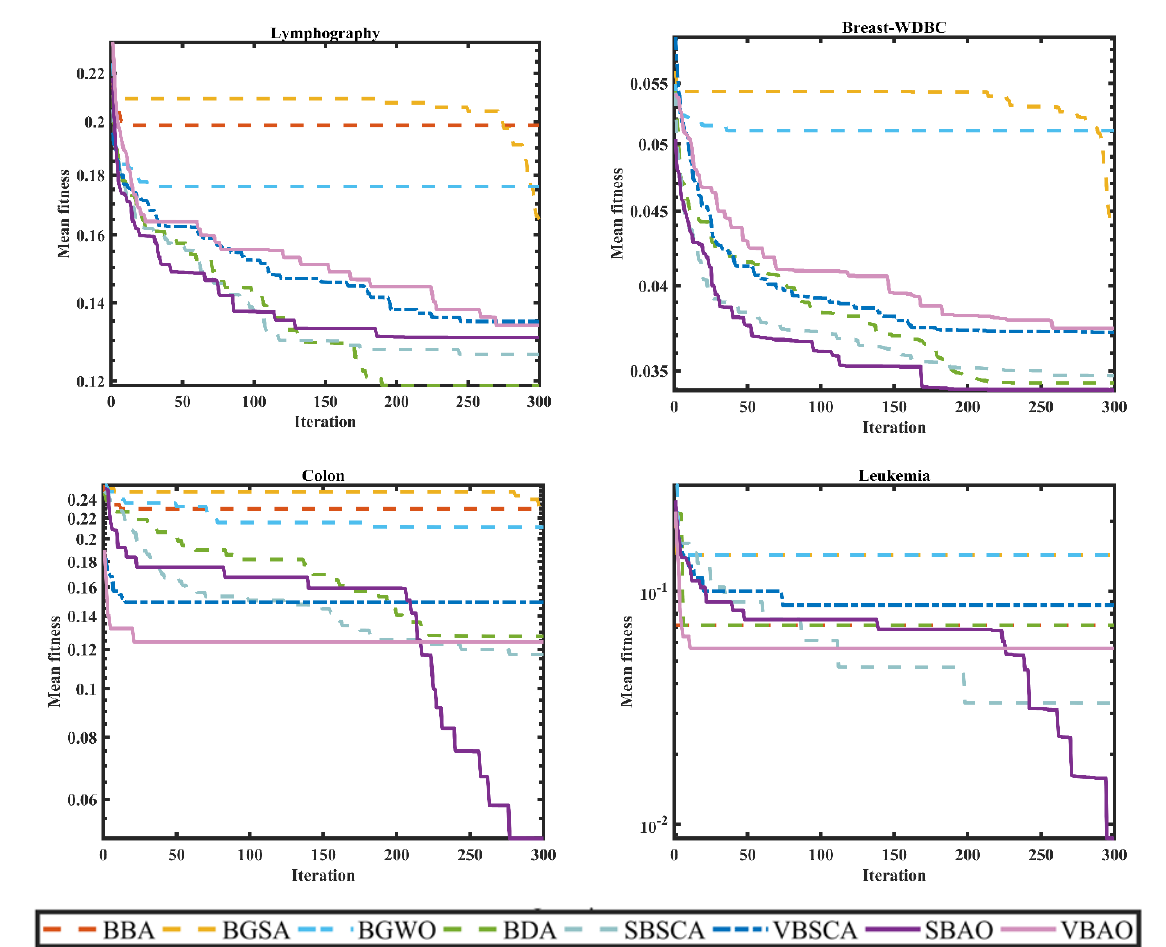
Figure 5. The convergence curves of BAO and comparative algorithms on all datasets.